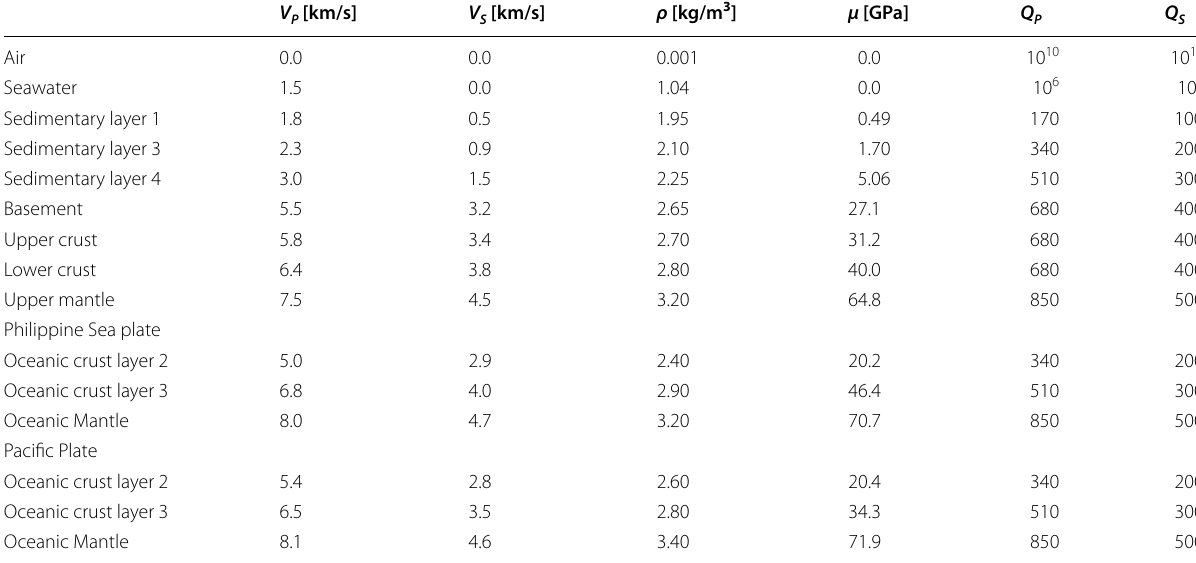
The air and seawater layers were treated as being the same, following Maeda et al. (2017). The P -wave velocity ( V P ), S -wave velocity ( V S ), density ( ρ ), rigidity ( μ ) and inelastic attenuation ( Q P and Q S ) are listed